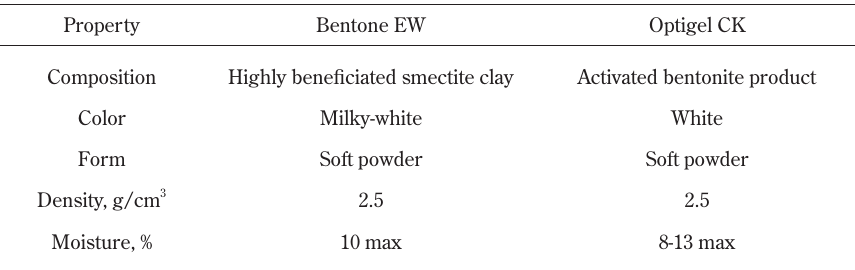
Table 5 Physical properties of Bentone EW and Optigel